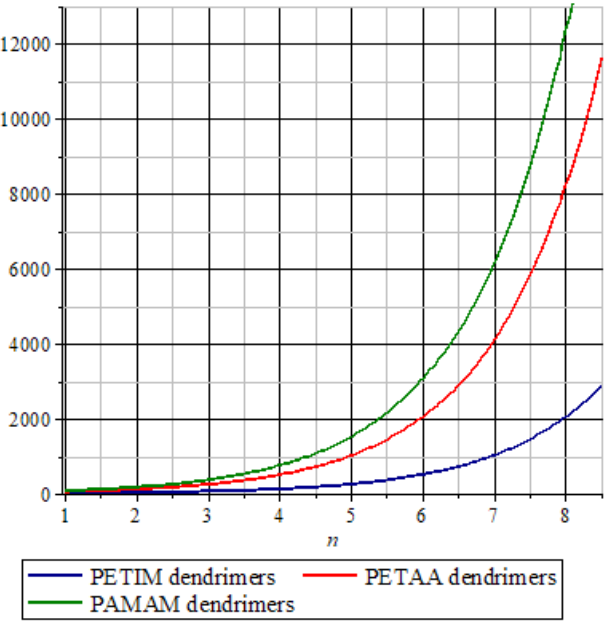
Figure 4. Albertson irregularity index.